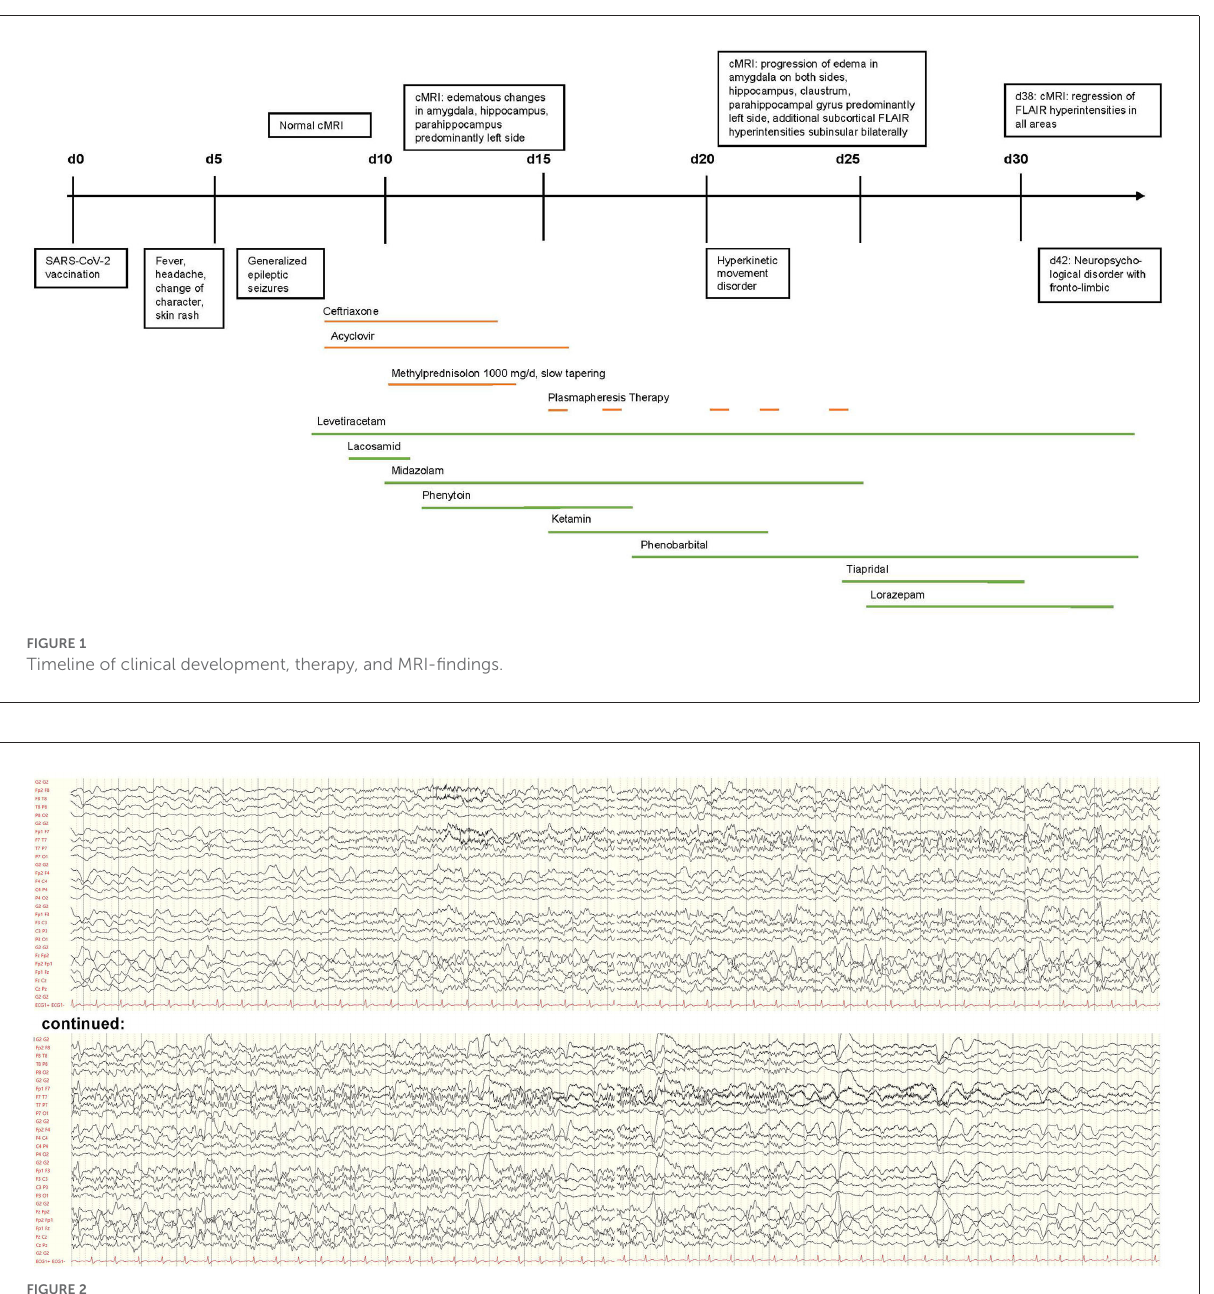
FIGURE2 Electroencephalogram on day 8 after symptom onset showing a brief focal seizure. The seizure discharge begins with an evolving fast rhythm with onset in the left temporal leads and interspersed epileptic discharges. There is generalized background slowing following the seizure. Bipolar longitudinal montage, gain 70 µ V/cm, base time 3 cm/s, high-pass filter. 53Hz, low-pass filter 80Hz, and notch filter